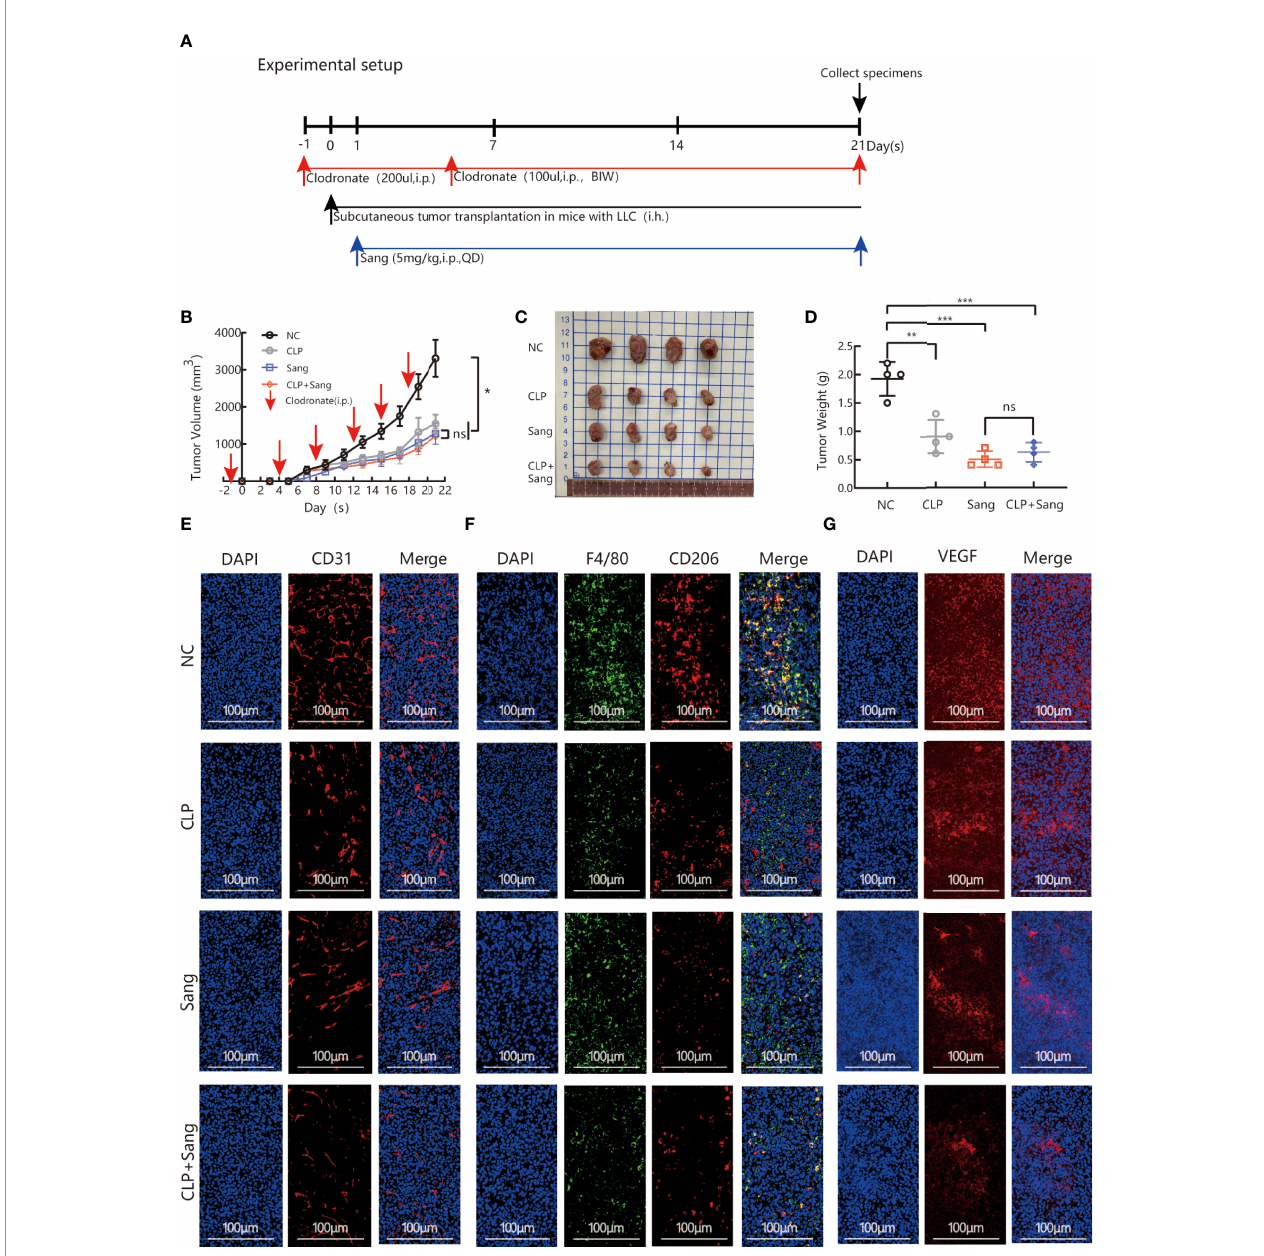
FIGURE 4 | Sang inhibits tumor growth and neovascularization in mice by suppressing macrophage M2 polarization. CLP (200 µl/mouse) was intraperitoneally administered on the day before starting tumor inoculation (day -1). A total of 5 × 105 LLCs per mouse were subcutaneously injected into the right fl ank of C57BL/6 mice (day 0), and then 100 µl of CLP per mouse was administered by intraperitoneal injection on days 4, 8, 12, 15 and 19 and Sang (5 mg/kg) from day 1. Tumor size was measured every 2 days, and following treatment for 3 weeks, the mice were sacri fi ced and tumor tissues isolated. Data are presented as the mean ± SEM of measurements from fi ve mice per group. *p < 0.05; **p < 0.01; ***p < 0.001; ns, not statistically signi fi cant (p > 0.05). (A) Experimental setup for depletion of macrophages in the Lewis lung subcutaneous transplantation mouse model. (B) Tumor volume curves; (C) Tumor tissues collected at the end point; and (D) Tumor weights. (E) The expression of CD31, (F) F4/80 colocalization with CD206, and (G) VEGF in the subcutaneous tumor tissue of lung cancer in macrophage-cleared mice was revealed by immuno fl uorescence staining. Nucleus was stained with DAPI solution. Scale bars: 100, 100, and 100 m m, respectively. In vivo , Sang reduced the secretion of VEGF by inhibiting M2 polarization, which ultimately resulted in inhibition of angiogenesis and tumor growth in